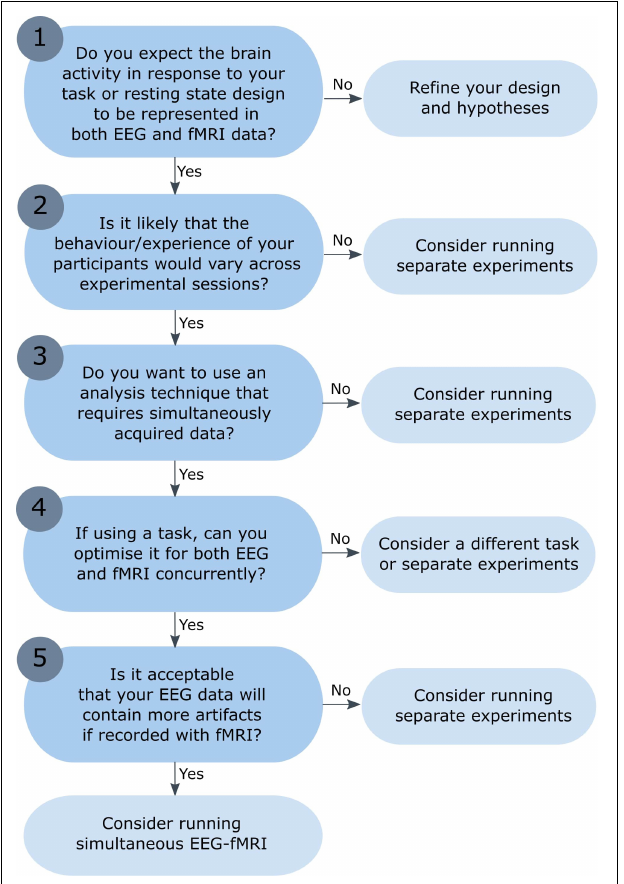
FIGURE 1 | Flow chart: is simultaneous EEG-fMRI necessary? The numbered questions correspond to numbered sections of the text, which describe each question and the possible outcomes in more detail. While the experimental process will not necessarily take the linear progression presented here, the aim is to offer a set of key questions to answer before undertaking simultaneous EEG-fMRI recording. The reader is directed to the critical literature referenced throughout each section to aid them in their response to each